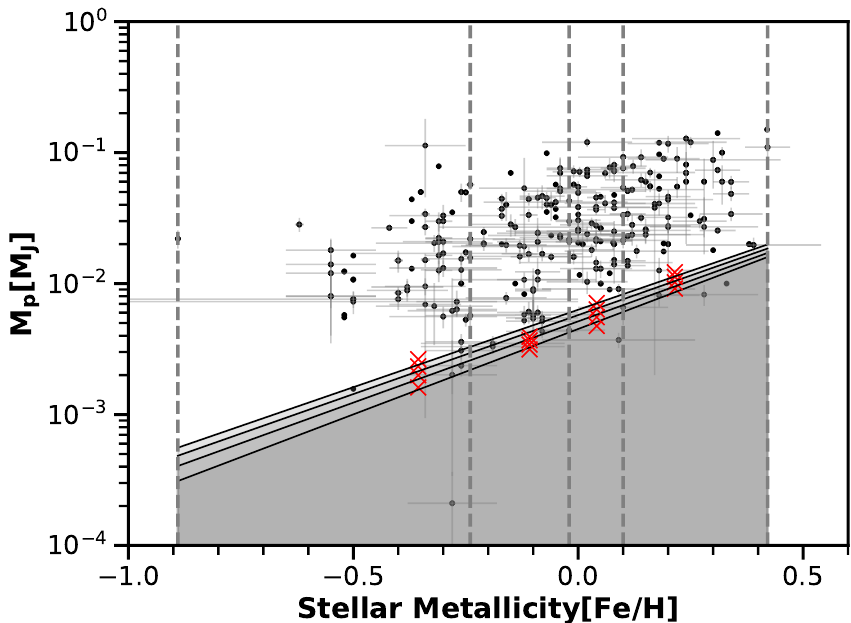
Figure 8. The gray dashed lines mark the four bins, and the red crosses mark the minimum mass of the bin with different cutoff limits of 3%, 4%, 5%, and 6% separately. The lower boundary is computed by linear regression of the minimum mass and the shadow zone indicates the planet desert below the mass lower